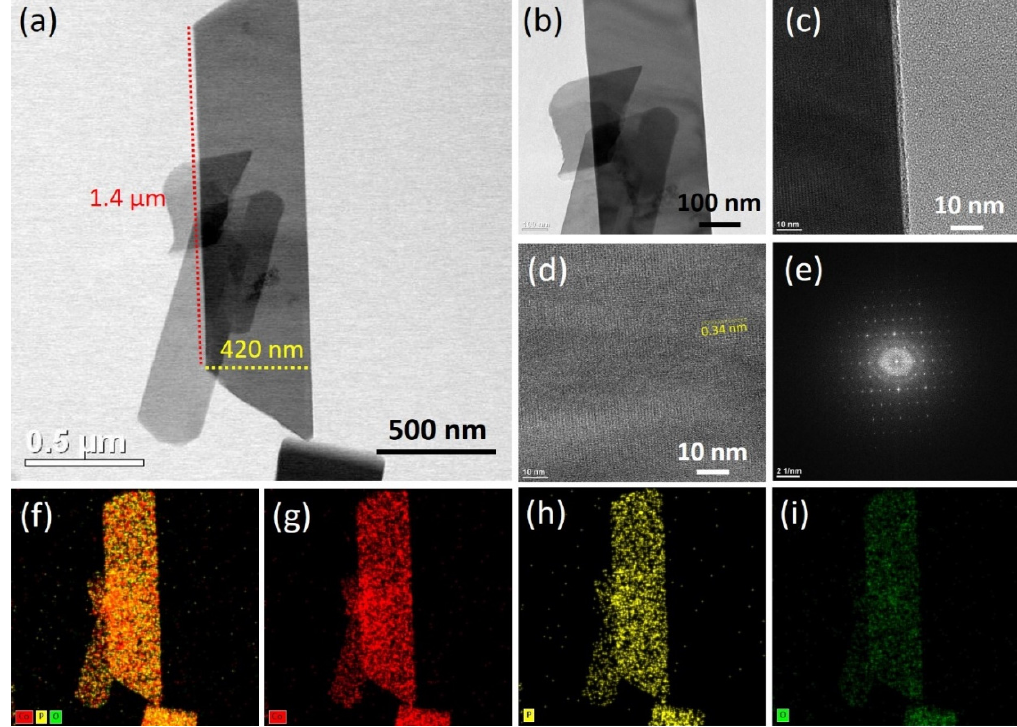
Figure 3. ( a – d ) TEM images of the Co 2 P 2 O 7 materials synthesized at optimized deposition tempera- tures of 150 °C, respectively, ( e ) SAED pattern, ( f – i ) elemental mapping of the optimized Co 2 P 2 O 7 materials, respectively.